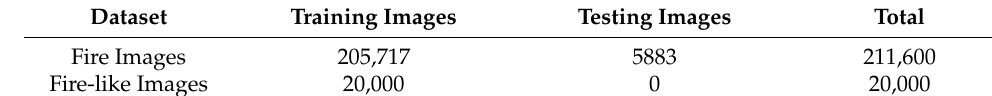
Table 2. Distribution of fire and fire-like images in the dataset.